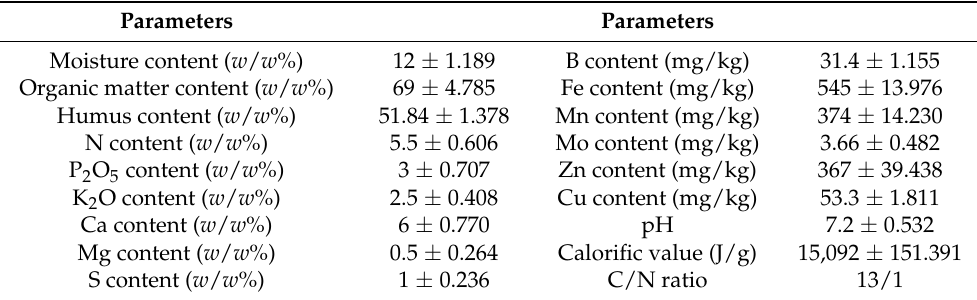
Table 2. Parameters of the end product.